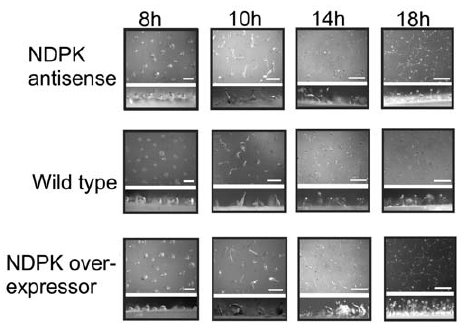
Figure 4. Multicellular development is unaffected by NDPK expression levels. The development of wild type, NDPK antisense and NDPK overexpressing cells was tracked over time and images recorded at the time points shown above the columns. Each panel includes an aerial view of the plate and a side view. All strains developed at a similar rate indicating that NDPK has no effect on the time course of multicellular